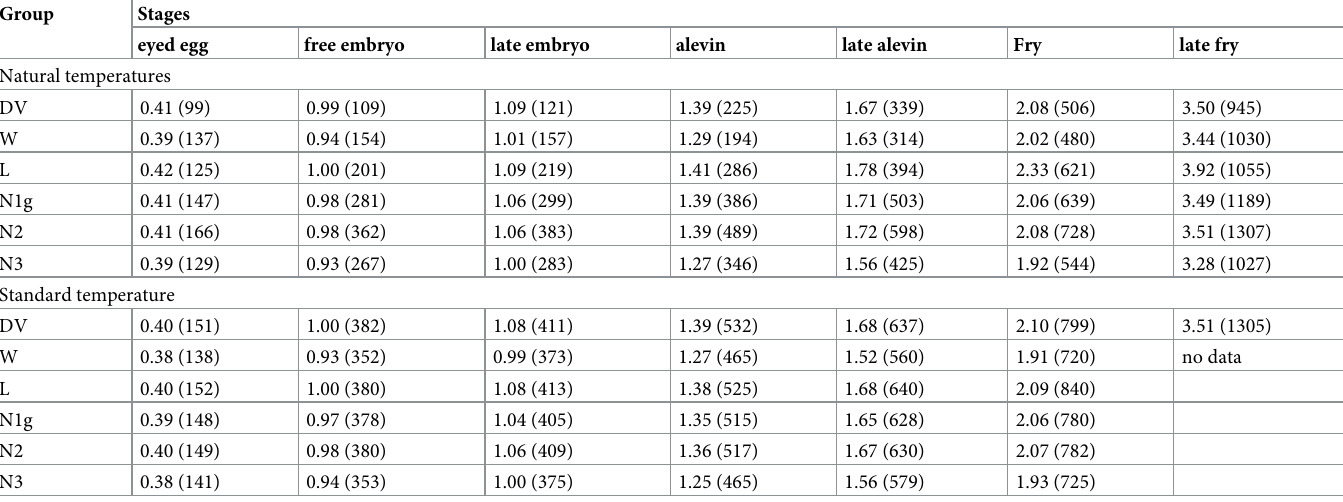
Table 1. Values of D( τ ) and dd (in brackets) for the experimentally reared charrs during 50% transition to the next developmental stage. Group